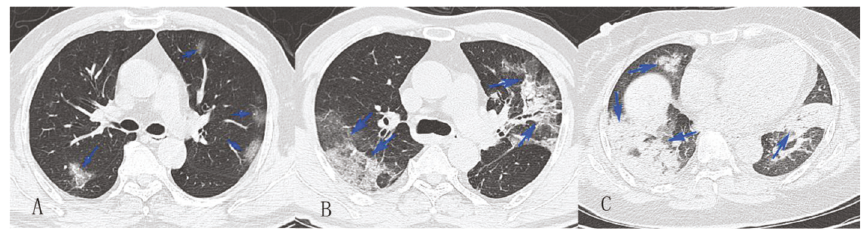
Figure 1: CTgrading. (a) Mild pneumonia (peripheric and subpleural damping as ground glass). (b) Moderate pneumonia (thick shadow with multiple lung lobes ( ≥ 3) affected; cloudy flocculent or stone like lesions; local lobes consolidation ( ≥ 2); lobes fibrosis or sign of air bronchograms). (c) Severe pneumonia (consolidation with a minimum of 80% of the pulmonary or 4 lobes involvement; strip-shaped lesion and significant